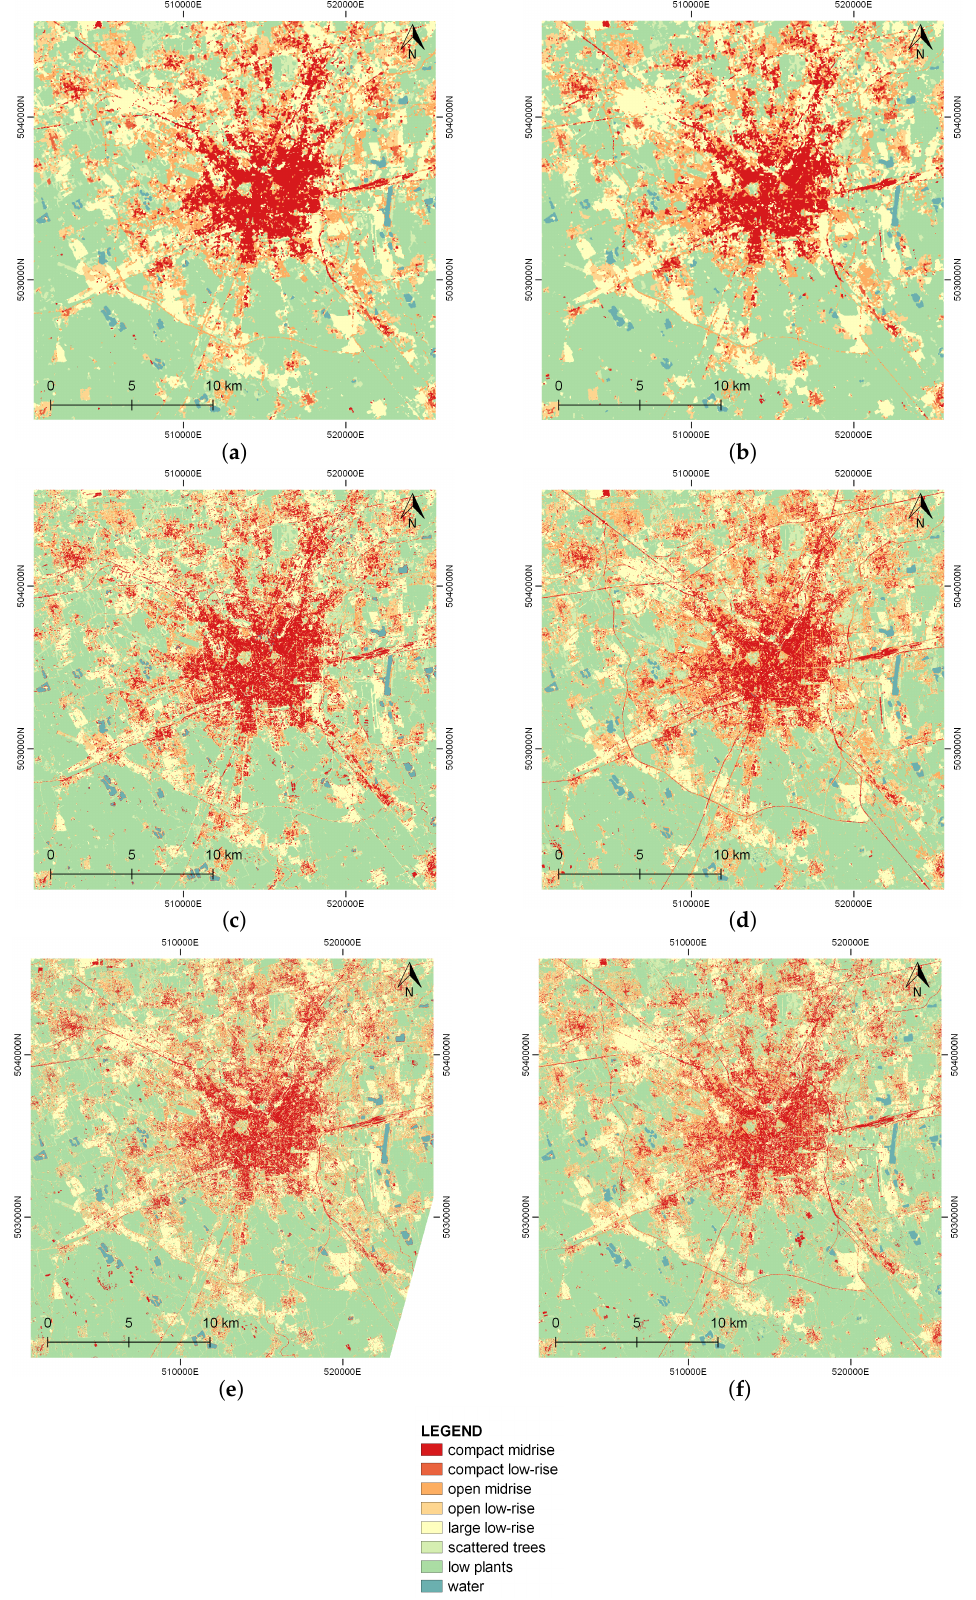
Figure 5. LCZ final maps: ( a ) Landsat 8, non-vegetative period; ( b ) Landsat 8, vegetative period; ( c ) Sentinel-2, non-vegetative period; ( d ) Sentinel-2, vegetative period; ( e ) RapidEye, non-vegetative period; ( f ) RapidEye, vegetative period. CRS: WGS84/UTM zone 32